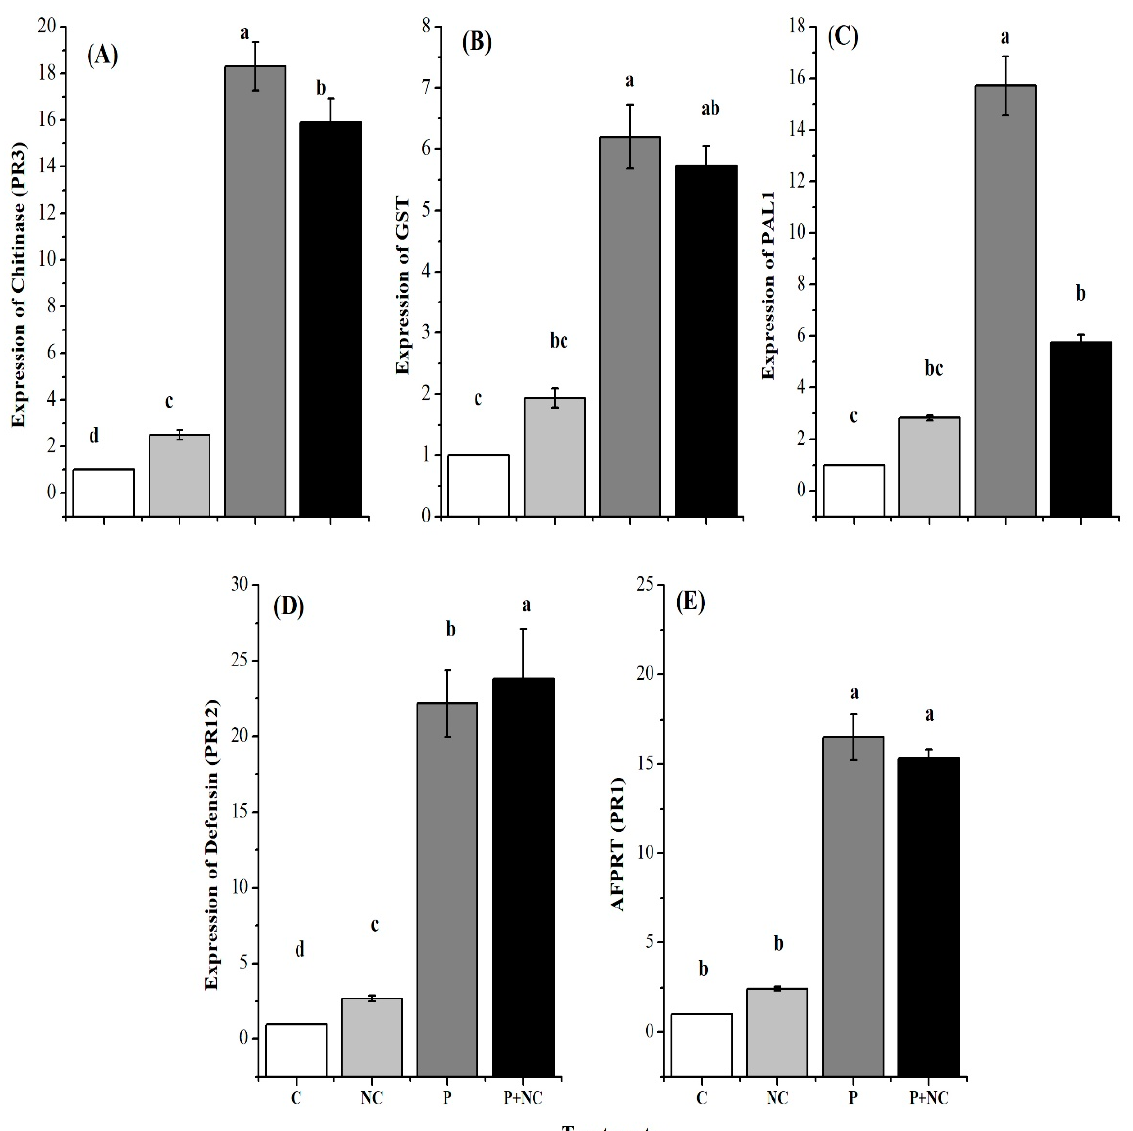
Figure 5. Different plant defense related genes expression after treatments. Expression of Chitinase ( A ), Glutathione-S- transferase ( GST ) ( B ), Phenyl ammonia lyase PAL1 ( C ), Defensin ( D ), and Pathogenesis-related protein ( AFPRT ) ( E ). Different lower-case letters indicate significant difference ( p ≤ 0.01) among the different treatments. Error bars indicate ± standard error of the mean of three replicates. Note: C for control, NC = plants treated with nano-fertilizer with Ag/CHI NC, P = plants treated with R. solani , (P + NC) = pots inoculated with R. solani and Ag/CHI NC solution (50 mL) twice a day for three days.